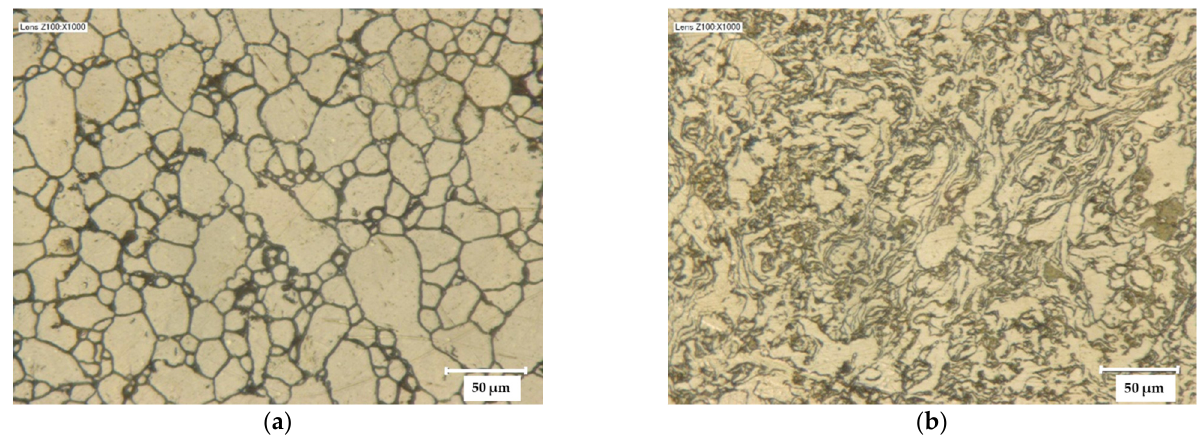
Figure 5. Optical images of the sintered samples: ( a ) AA7075-S, ( b ) AA7075-MS.